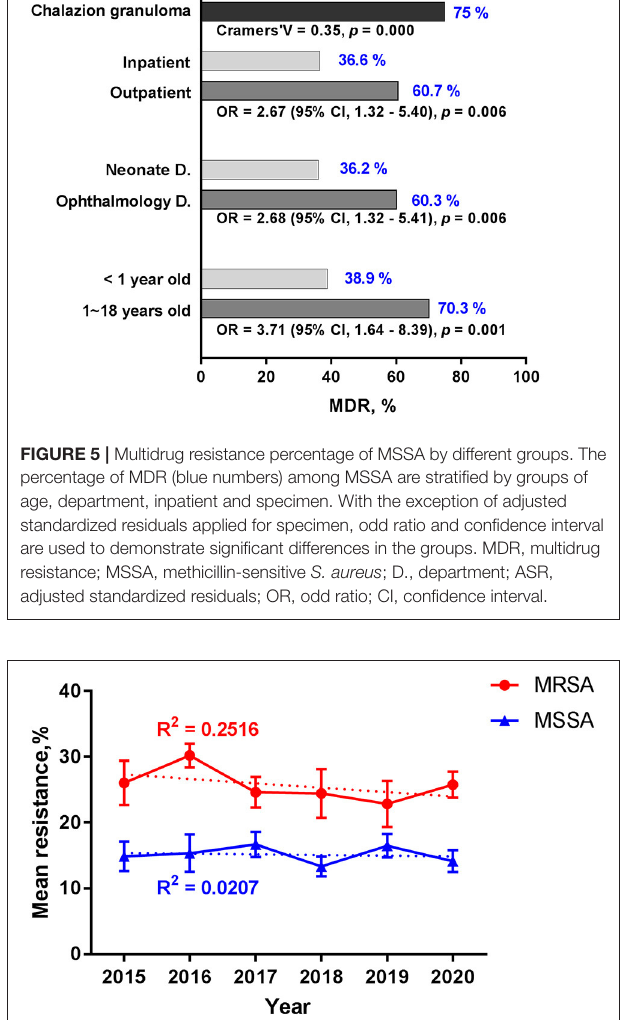
FIGURE 4 | Multidrug resistance among S. aureus isolates. (A) MDR for MRSA. (B) MDR for MSSA. (C) Change of MDR percentage over time. The percentage of MDR for MRSA and MSSA isolates stratified per year are shown in red and blue, respectively; trend lines are shown as the dotted ones, with the correlation coefficient R 2 = 0.0859 and 0.3644 for MRSA and MSSA, respectively. MDR, multidrug resistance; MRSA, methicillin-resistant S. aureus ; MSSA, methicillin-sensitive S. aureus .